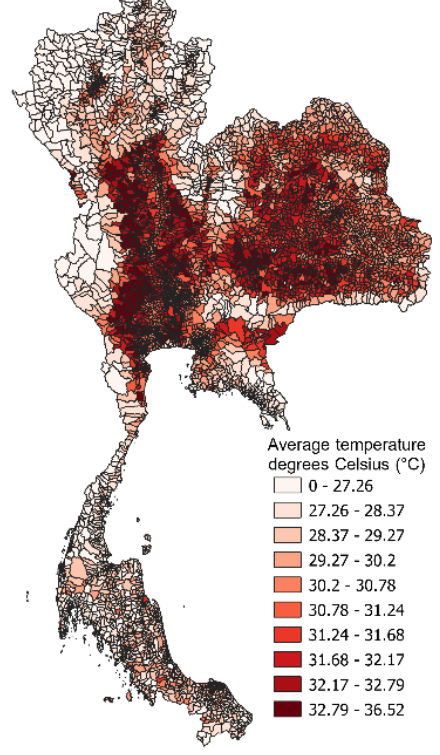
Figure 5. Spatial distribution of Land Surface Temperature (Day) in 2017. Source: Google Earth Engine.